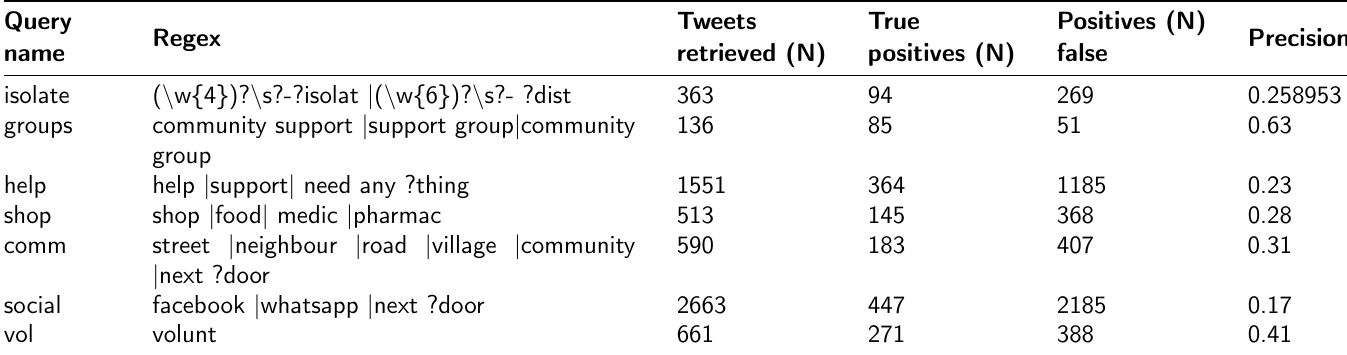
Supplementary Table 2: Summary of the regex rules used to find tweets relating to community support